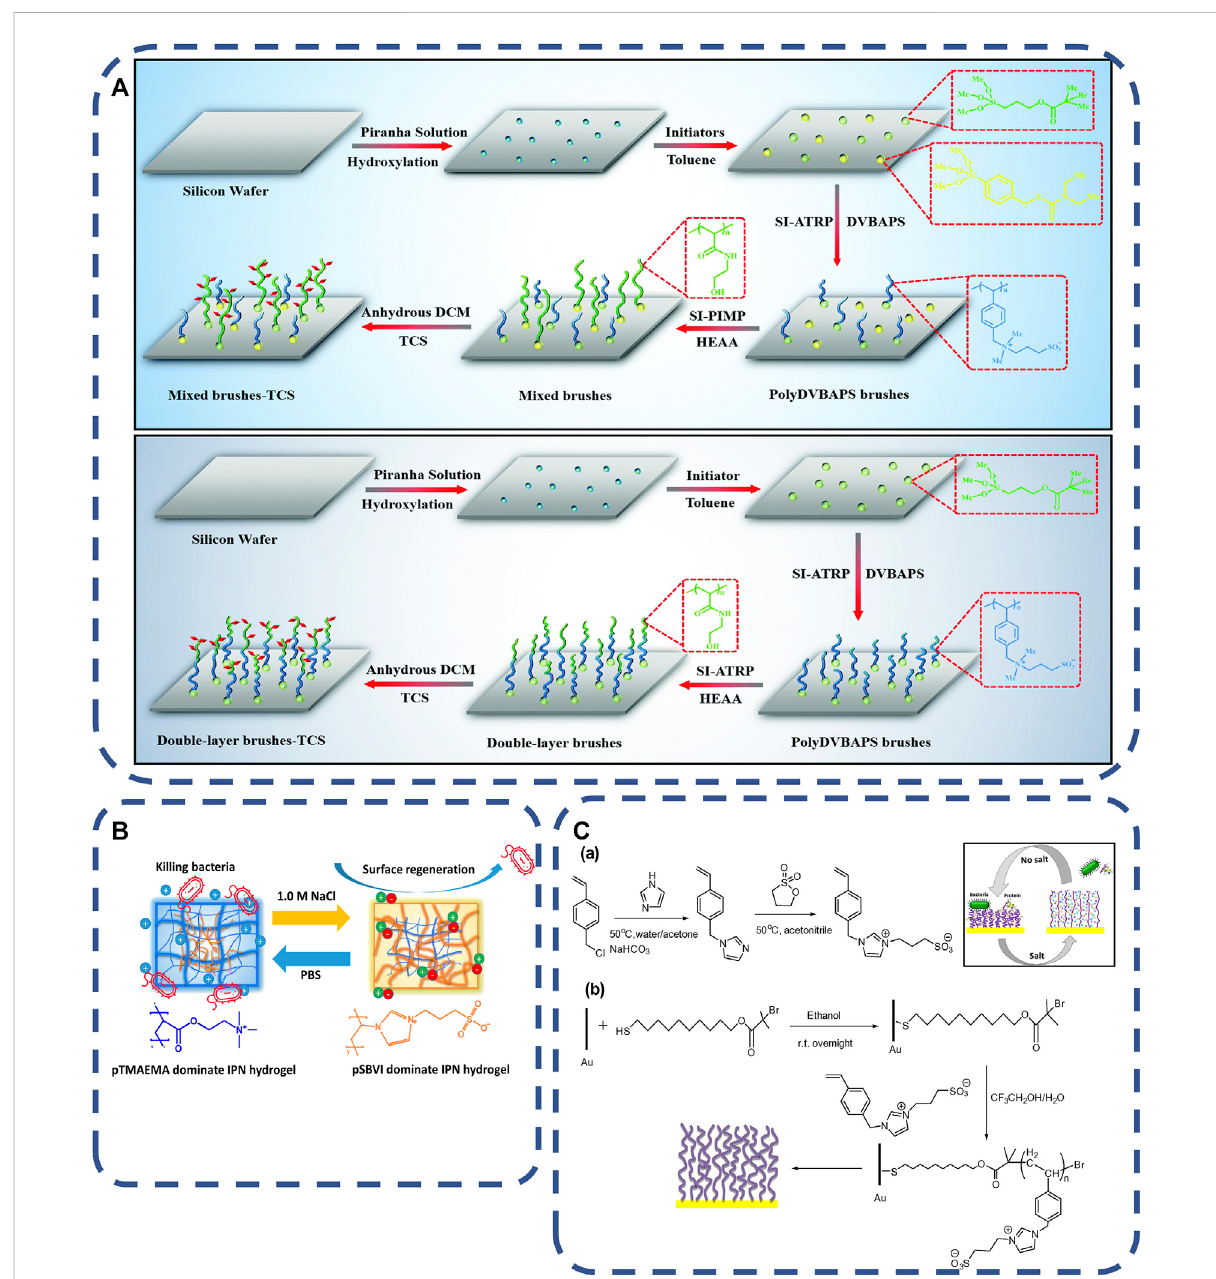
FIGURE 2 (A) Schematic of the two types of antibacterial polymer brushes with hierarchical structures of a mixed polyDVBAPS/polyHEAA brush and a double-layer poly (DVBAPS-b-HEAA) brush (Wang et al., 2019). Copyright 2019, J Mater Chem B. (B) schematic diagram of exchangeable salt to kill bacteriaandIPNhydrogel toreleasebacteriainPBSandNaClsolutions(Huangetal.,2019).Copyright2019,Biomacromolecules. (C) (a)Synthesisof VBIPS monomer in response to salt and (b) schematic diagram of SI-ATRP process by brushing the poly vein double shrinkage analyzer to the gold surface coated with fi xed initiator (Chen et al., 2016). Copyright 2016, Acta